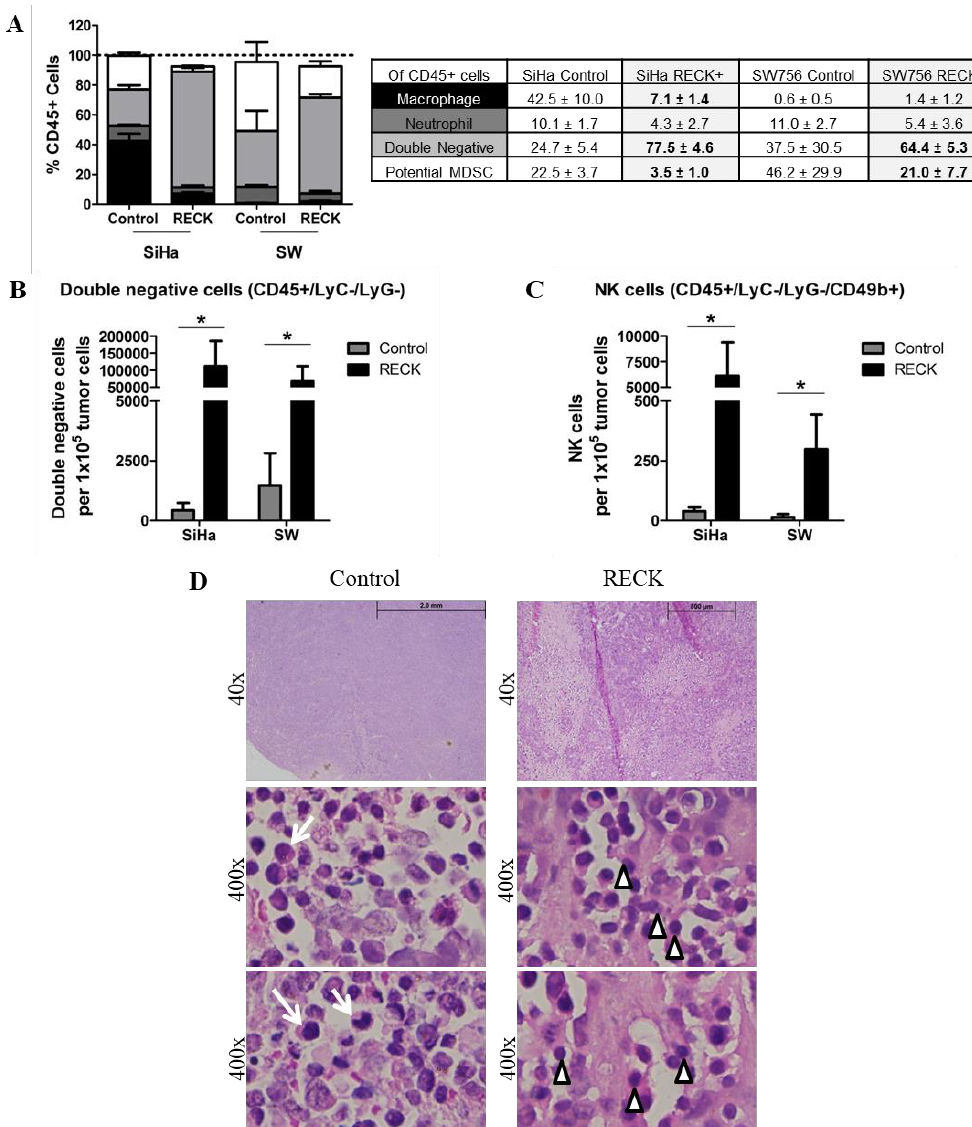
Figure 4. RECK over expression is associated with increased proportion of specific inflammatory infiltrate cell populations. ( A ). Intra-tumoral populations were characterized by immunostaining with CD45, Ly6C, Ly6G, F4/80 and CD49b antibodies, followed by flow cytometry. Tumor fractions of at least three animals from each group were used for the analysis and at least 1 × 10 5 cells/events were acquired. Significant differences in population proportion are indicated in bold font in the table. ( B , C ). Proportion of Double negative ( B ) and NK cells ( C ) relative to 100,000 tumor cells. ( D ). Representation of hematoxylin/eosin tumor sections used for morphology evaluation of the inflammatory infiltrate in SW756 RECK+ tumors. White arrows identify cells with monocyte and macrophage morphology and white arrow heads indicate lymphoid phenotype cells. * p < 0.05 by Kruskal – Wallis (4A) or Mann – Whitney (4B and 4C) test.